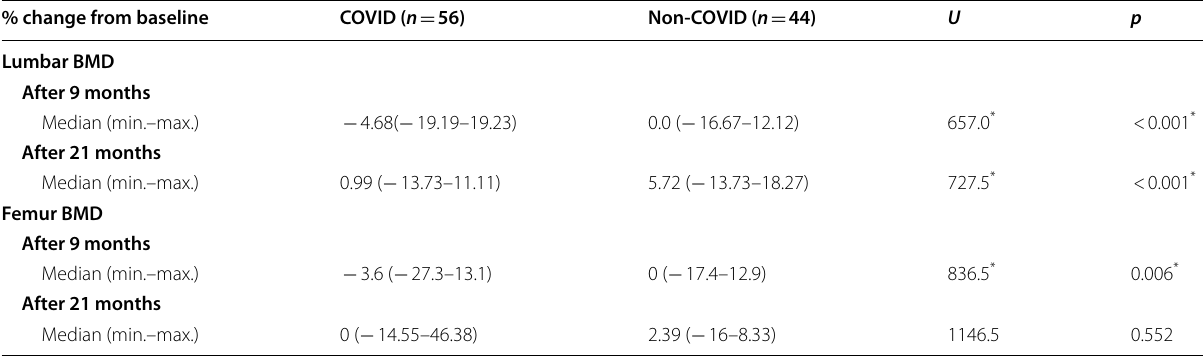
Table 4 Percentage of change in bone mineral density (BMD) at femur and lumbar spine after 9 and 21 months follow‑up in both groups